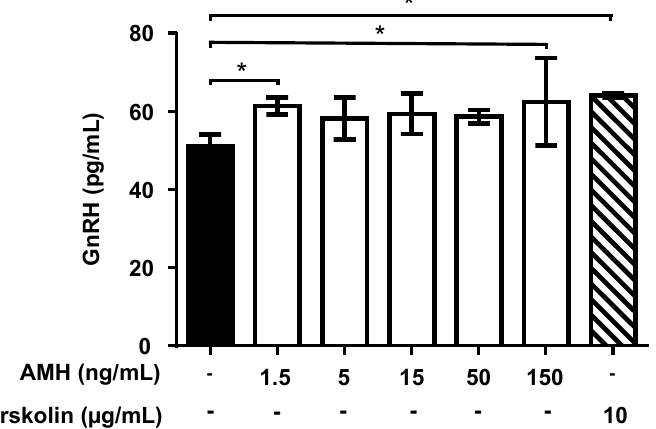
Figure 8. Effect of exposure to Anti-Müllerian hormone (AMH) on gonadotropin-releasing hormone (GnRH) release by GT1-7 cells. Cells were incubated for 90 min with different concentrations of AMH. Data are expressed as mean ± SD, n = 4. One experiment representative of three separate experiments is shown. * p < 0.05 vs. Control (black bar) (One-way ANOVA followed by the Dunnett post-hoc test).